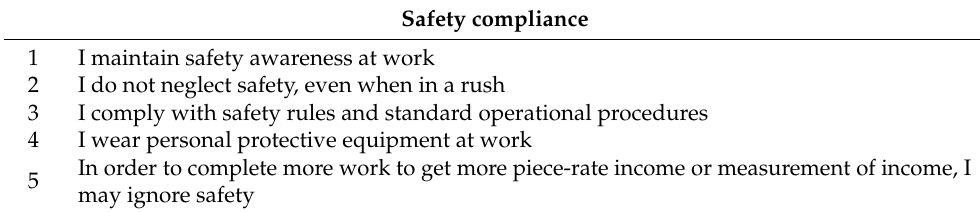
Table A2. Items of safety performance